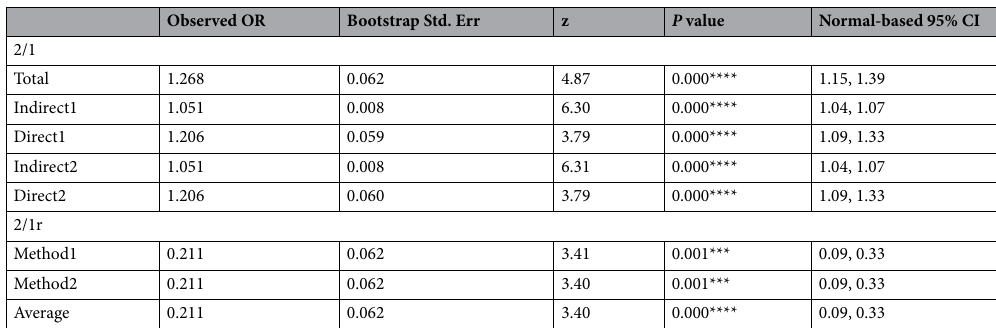
Table 3. Bootstrap results of the decomposition analysis estimating the mediating effect of truancy on the association between cigarette smoking and suicidal attempts. 2/1: the sizes of direct, indirect, and total effects of current smoking on suicide attempt. direct1: direct effect of current smoking according to decomposition method 1. direct2: direct effect of current smoking according to decomposition method 2. indirect1: represent the indirect effect of current smoking according to decomposition method 1. indirect2: represent the indirect effect of current smoking according to decomposition method 2. 2/1r: the sizes of the indirect effects relative to the total effects. Adjusted for age, gender, alcohol intake, drug use, physical activity, lack of sleep, parental involvement, physical violence, bullying, loneliness. **** p < ; *** p < 0.001; ** p < 0.01; * p < 0.05.